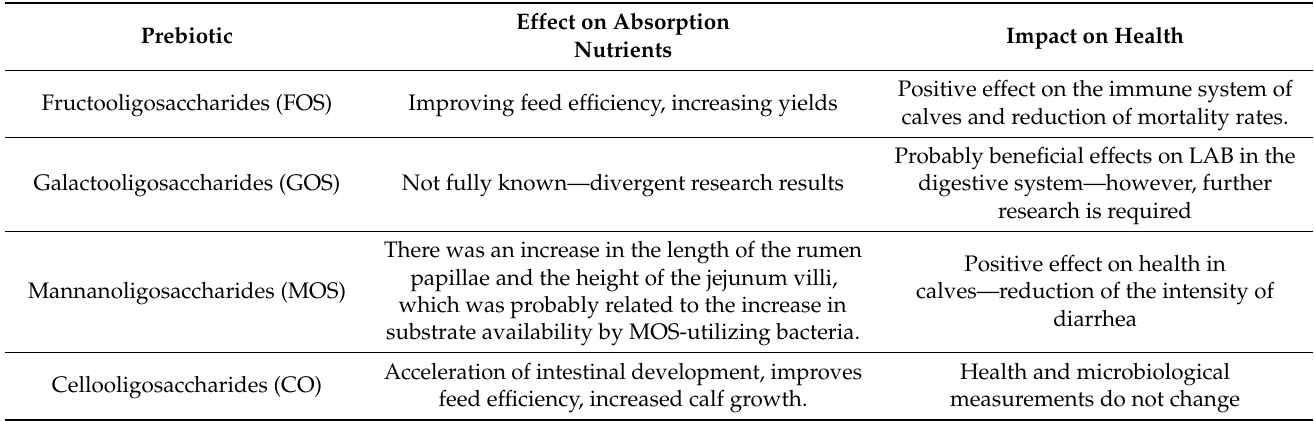
Table 2. Selected prebiotic substances and their action in the digestive system of ruminants [own study based on [56,58].